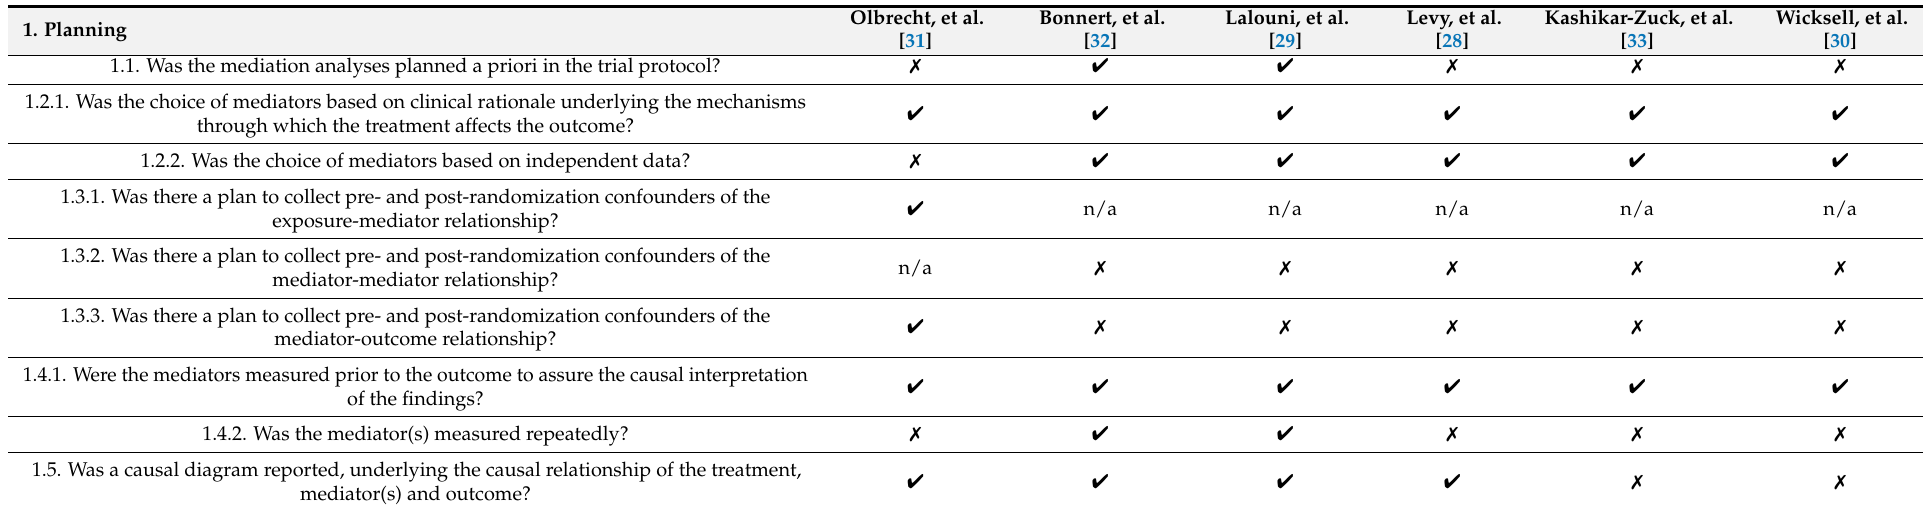
Table 2. Quality assessment in included